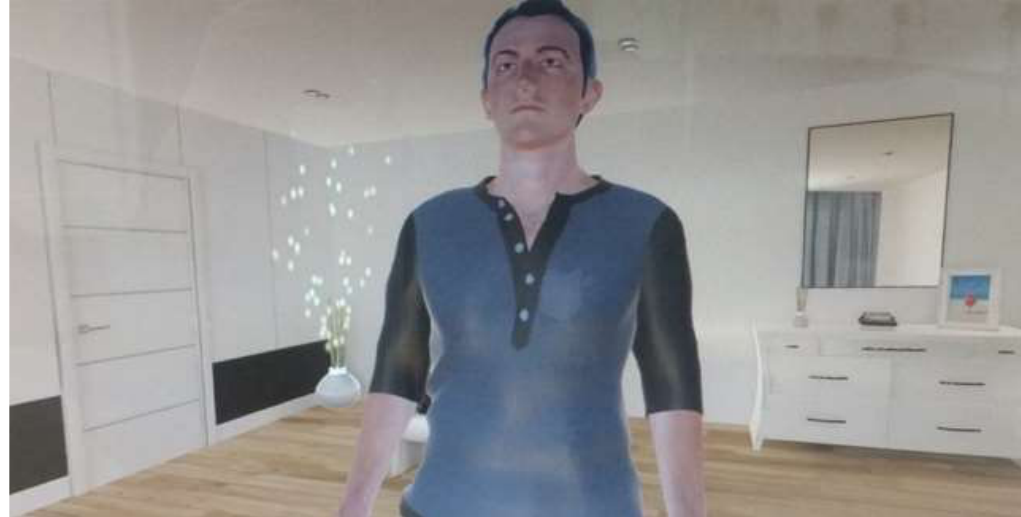
Figure 9. The immersive virtual reality environment as seen by the participant with the VH standing in a living room.